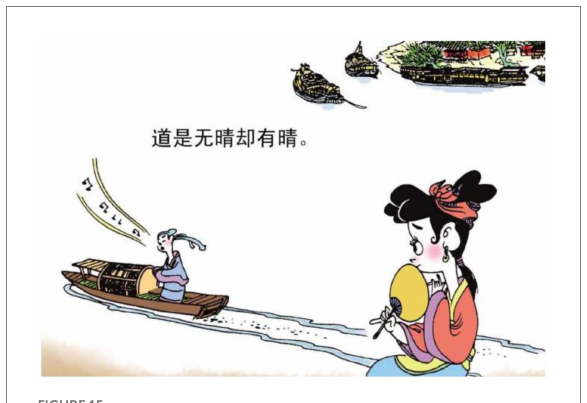
FIGURE 17 The fifth panel on Cai (2014, p. 132). Images reproduced with permission from Shang Dong People